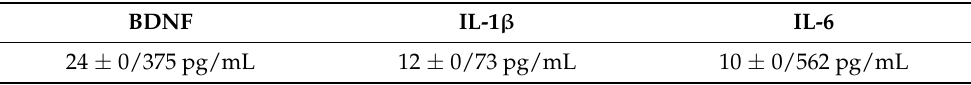
Table 1. The measurement of BDNF, IL-1 β , IL-6 in